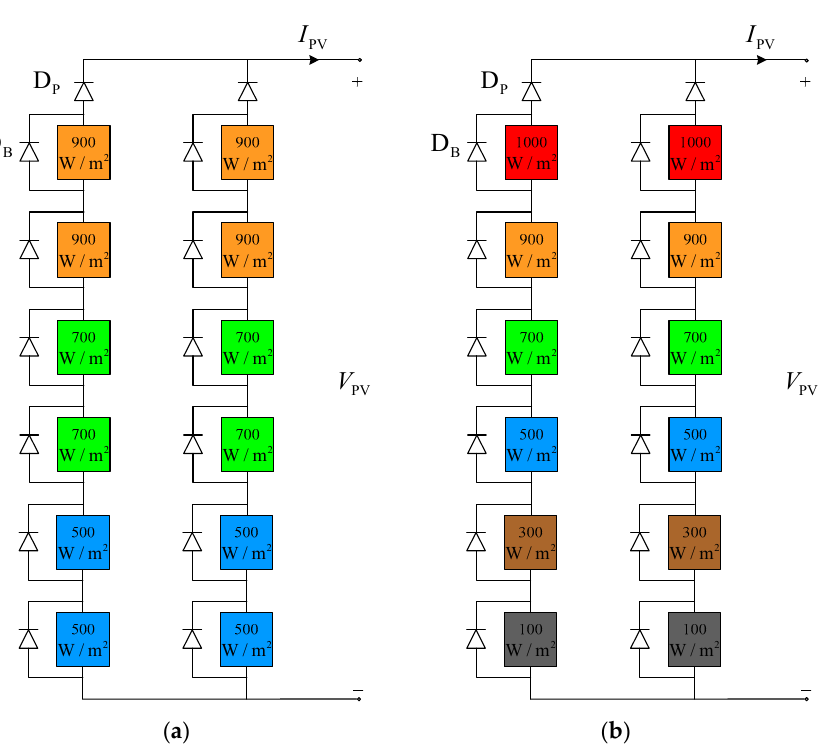
Figure 5. Control scheme for MPPT implementation.